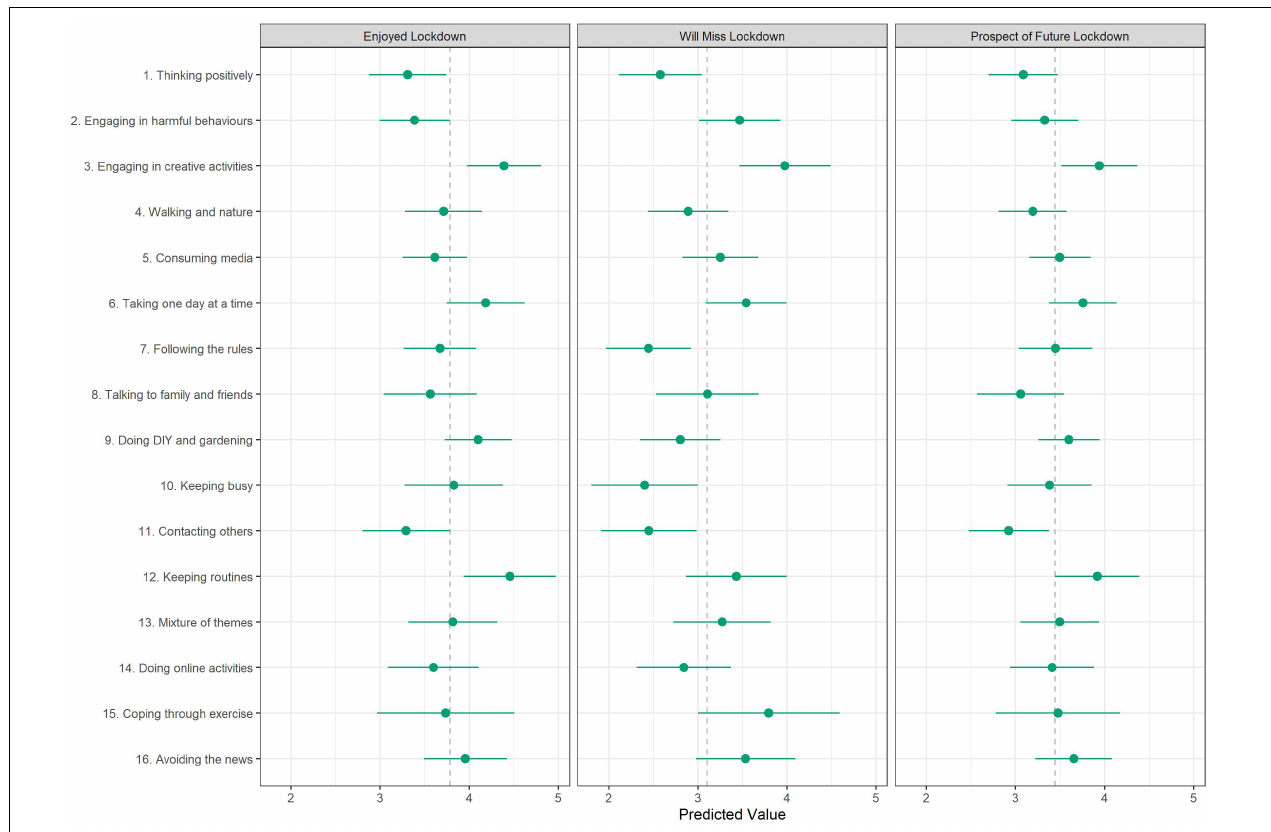
FIGURE 6 | Association between lockdown experiences and document topic proportions (+95% confidence intervals). Results displayed as predicted lockdown experience values where proportion devoted to a given topic is 100%. Derived from OLS regression models adjusting for all estimated proportions for all topics simultaneously. Dashed line represents mean value for the respective lockdown experience